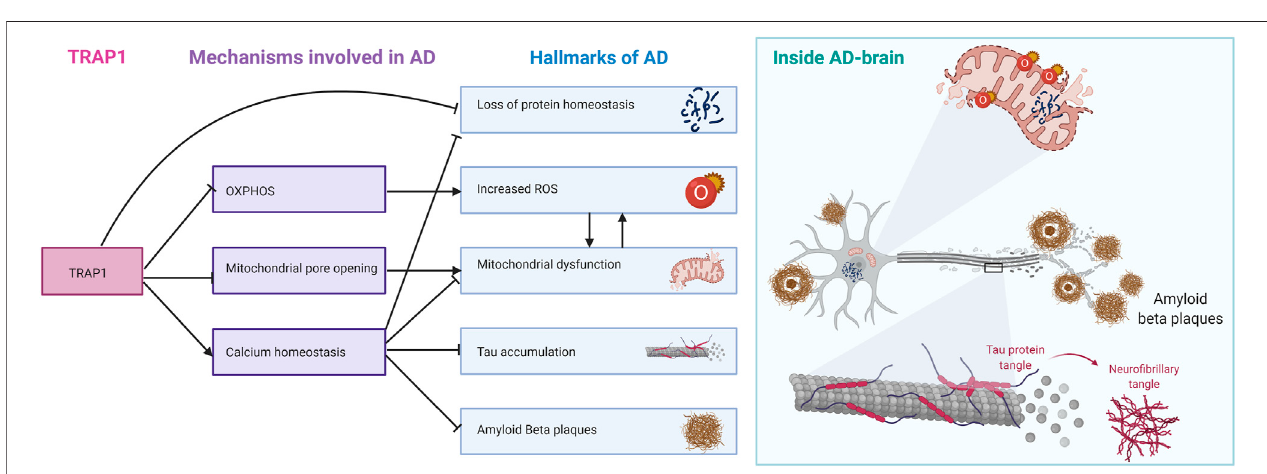
FIGURE7| TRAP1regulatorymechanismslinkedtodifferenthallmarksofAD.TRAP1regulationofOXPHOSislinkedtoincreasedROSformation,whichdamages mitochondria. Inhibition of mitochondrial pore opening by TRAP1 protects the mitochondria from swelling and rupture. TRAP1 is also involved in calcium homeostasis. Ca 2+ provestobeimportantinsignaling,anddisruptingcalciumhomeostasiscontributestohallmarkssuchasTauaccumulation,formationofAmyloidBètaPlaquesand protein homeostasis. As mitochondrial chaperone, TRAP1 is also directly involved in maintaining protein homeostasis. On the right, the hallmarks of AD are summarised around one neuron.